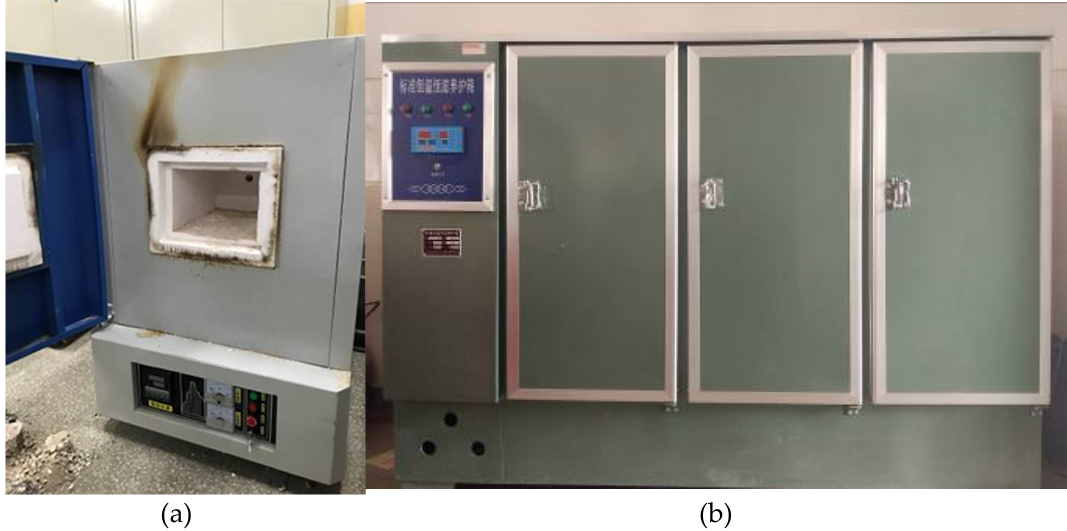
Figure 1. Equipment used for heating concrete specimens ( a ) and keeping the temperature constant ( b ).